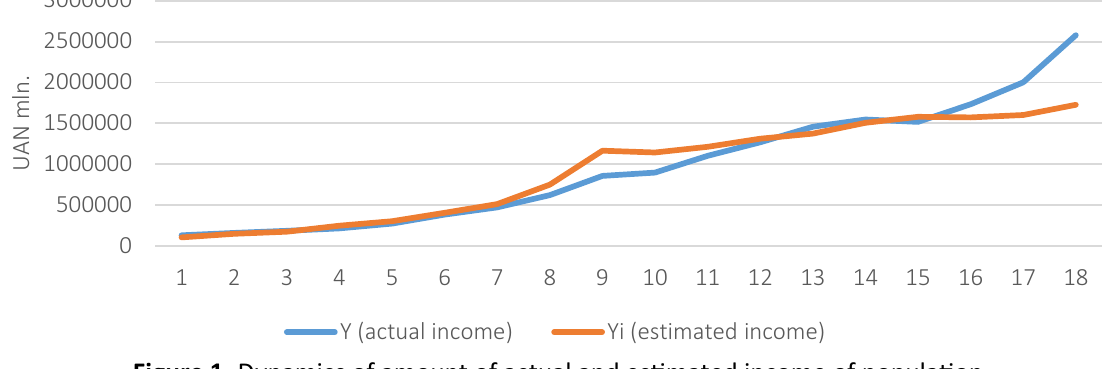
Figure 1. Dynamics of amount of actual and estimated income of population of Ukraine within 2000–2017, mln